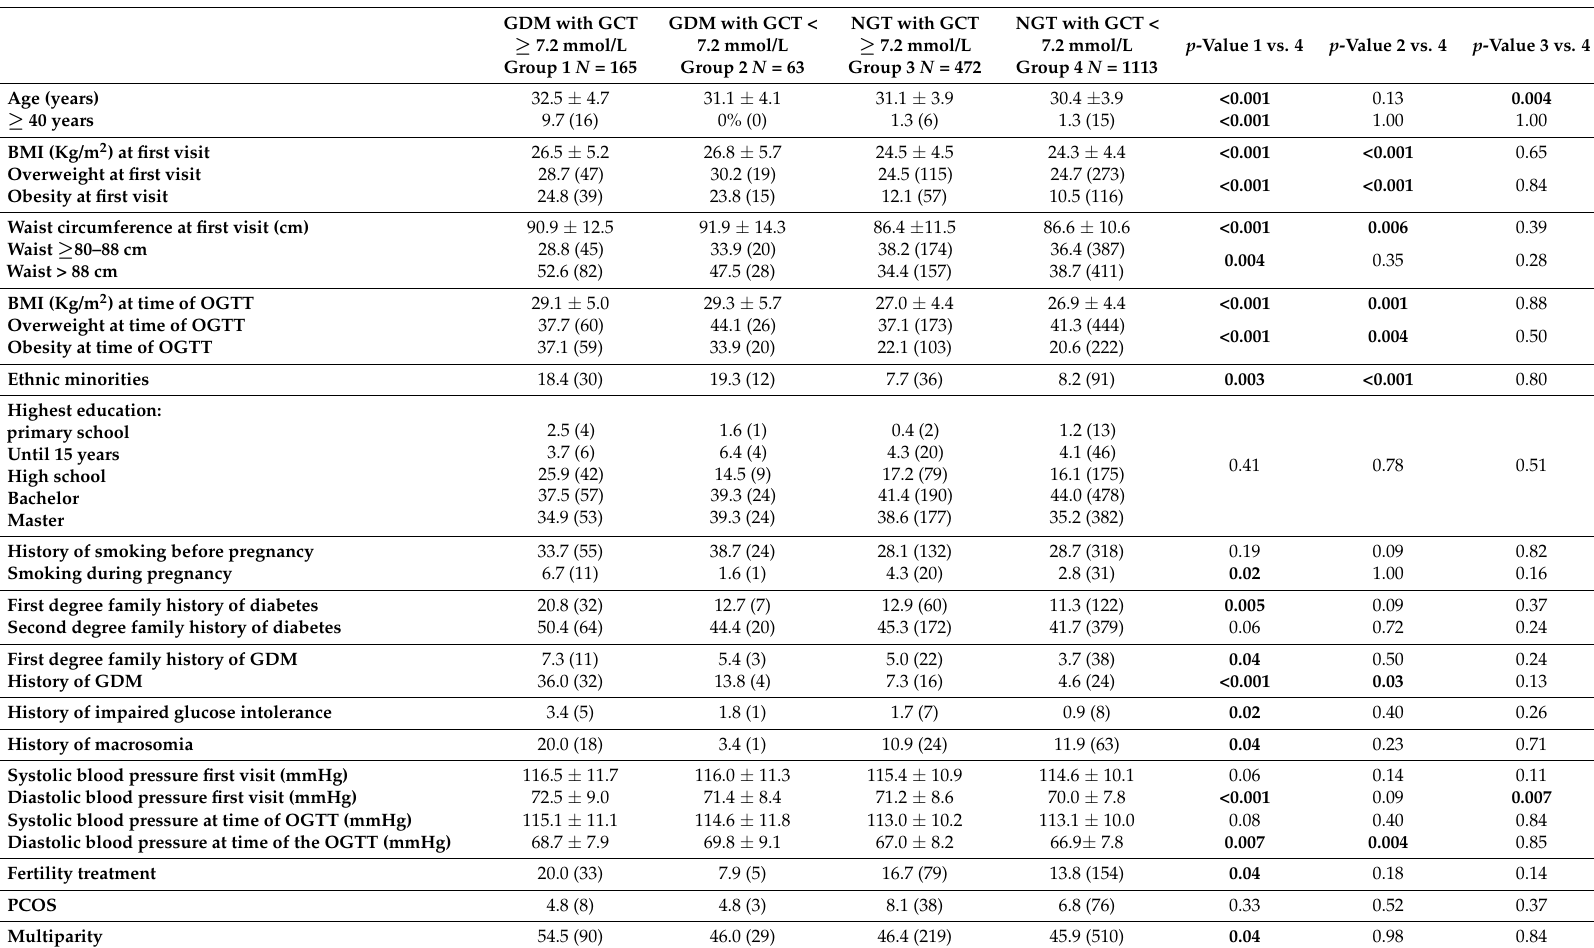
Table 3. Differences in characteristics across the four gestational tolerance groups according to the GCT and OGTT